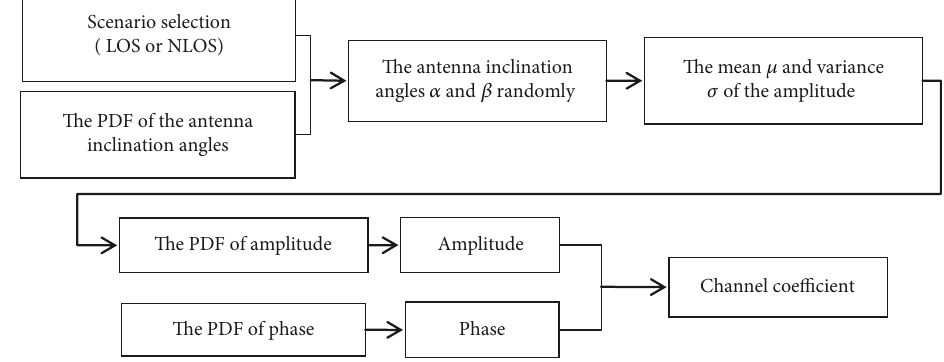
Figure 18: The fl ow chart of the process of generating channel coe ffi cients.